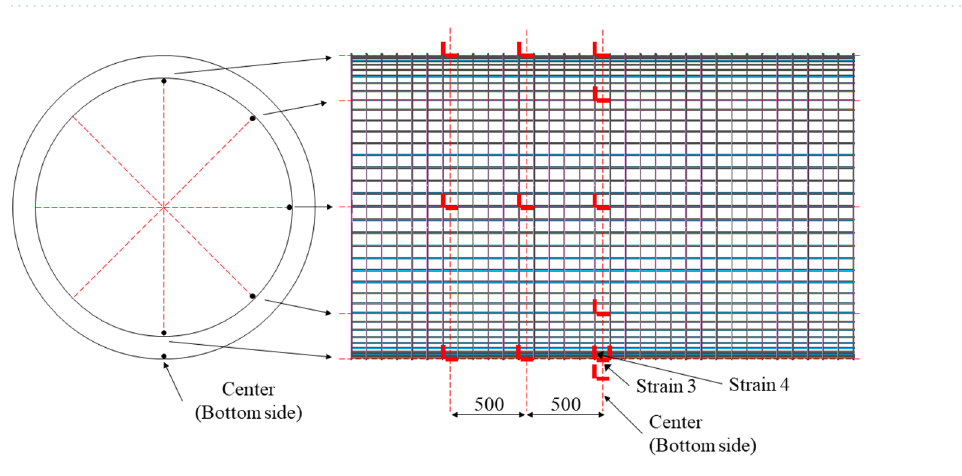
Figure 5. Strain gauge